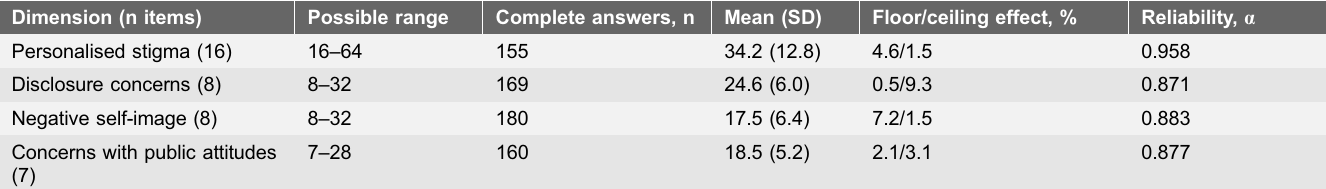
Table 4. Descriptive statistics for the subscales of the HIV stigma scale. Dimension (n